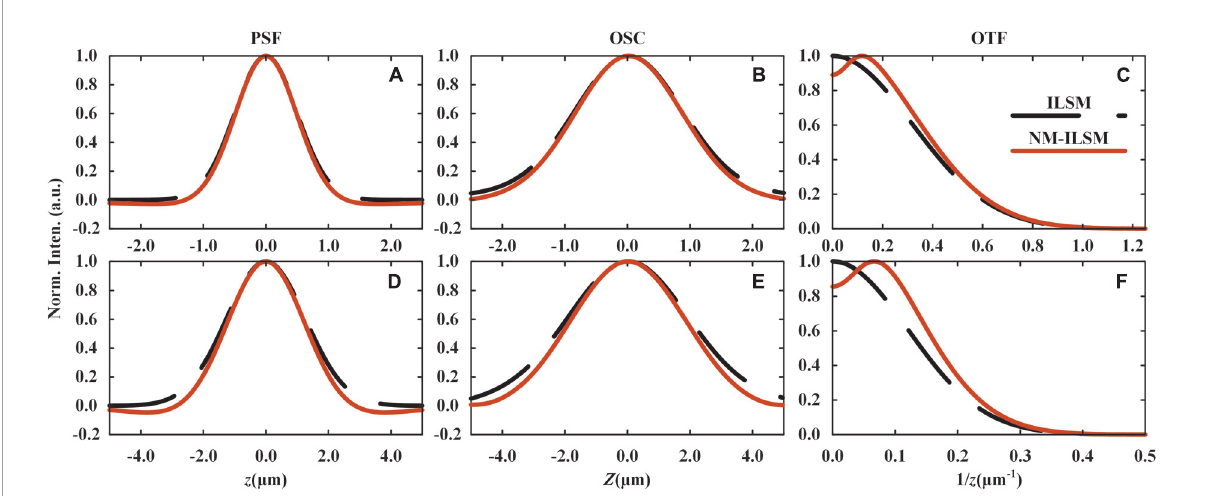
FIGURE2 Simulated imaging performances of ILSM and NM-ILSM. Axial PSFs, OSCs, and OTFs at the center (A–C) and the edge (D–F) of the